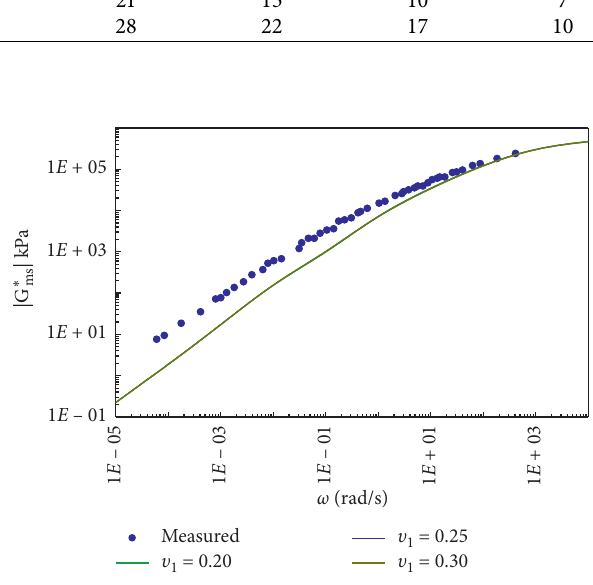
Figure 12: Effect of Poisson’s ratio of fillers on predicted | G ∗ | . ms